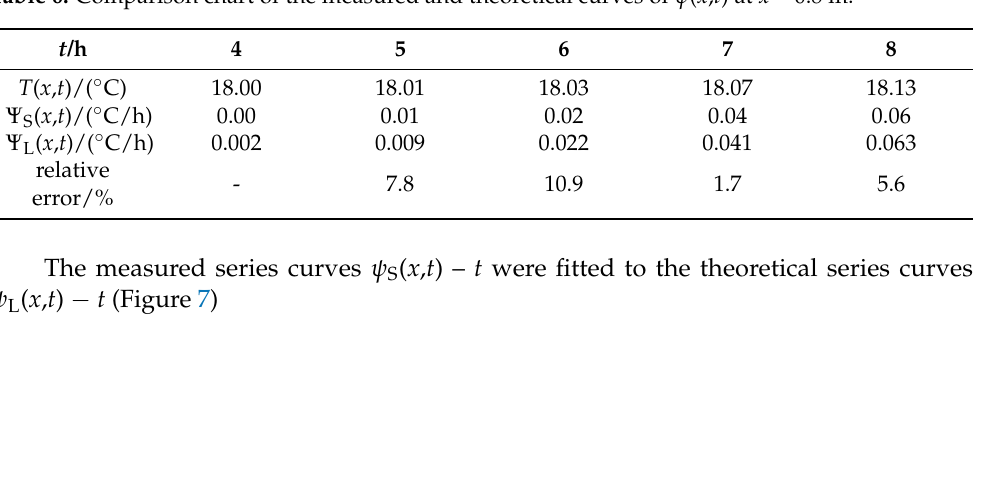
Table 6. Comparison chart of the measured and theoretical curves of ψ ( x , t ) at x = 0.8